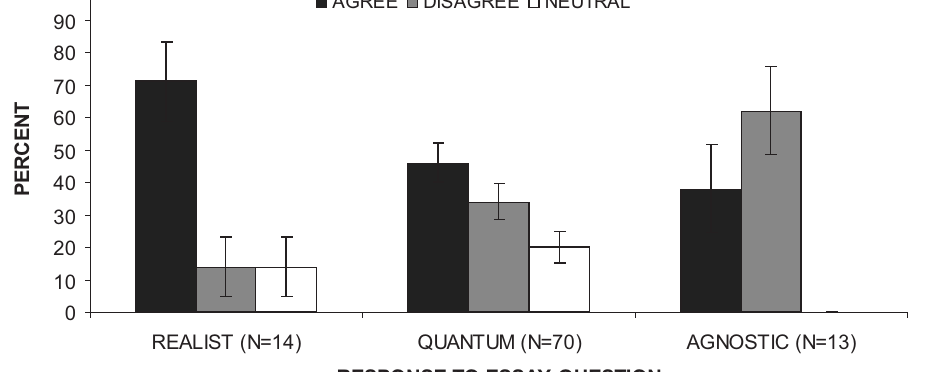
FIG. 8. Combined student re- sponses from both courses to the statement on atomic electrons, grouped by how students re- sponded to the essay question on the double-slit experiment (cid:1) error bars represent the standard error on the proportion (cid:2)